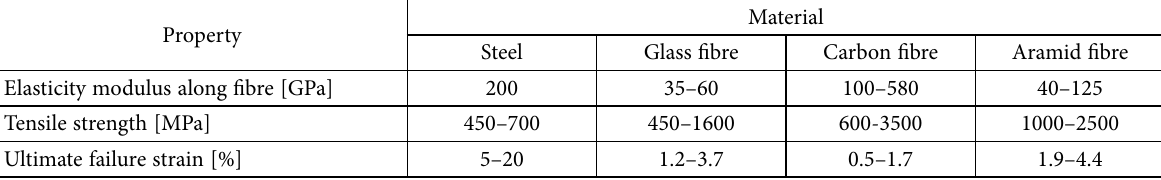
Table 2. The properties of composite and steel reinforcement, when fibre volume part is equal 0.5–0.75 (Kaklauskas et al.